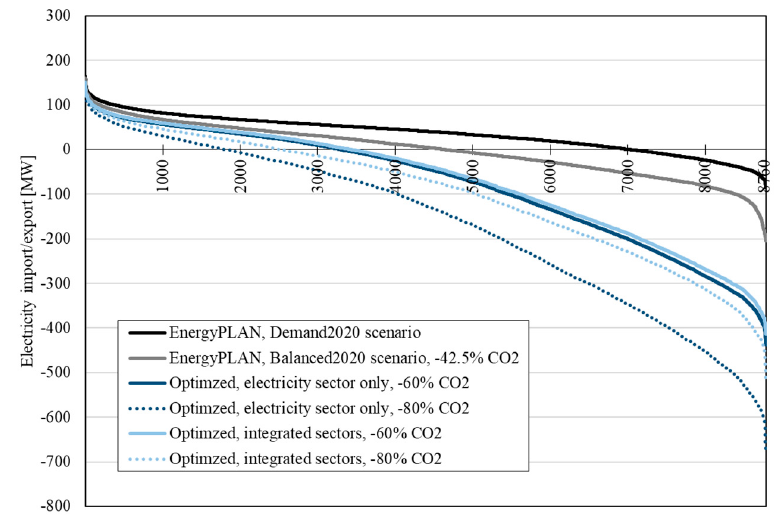
Figure 8. Duration curves for electricity import (positive)/export (negative) [MW].